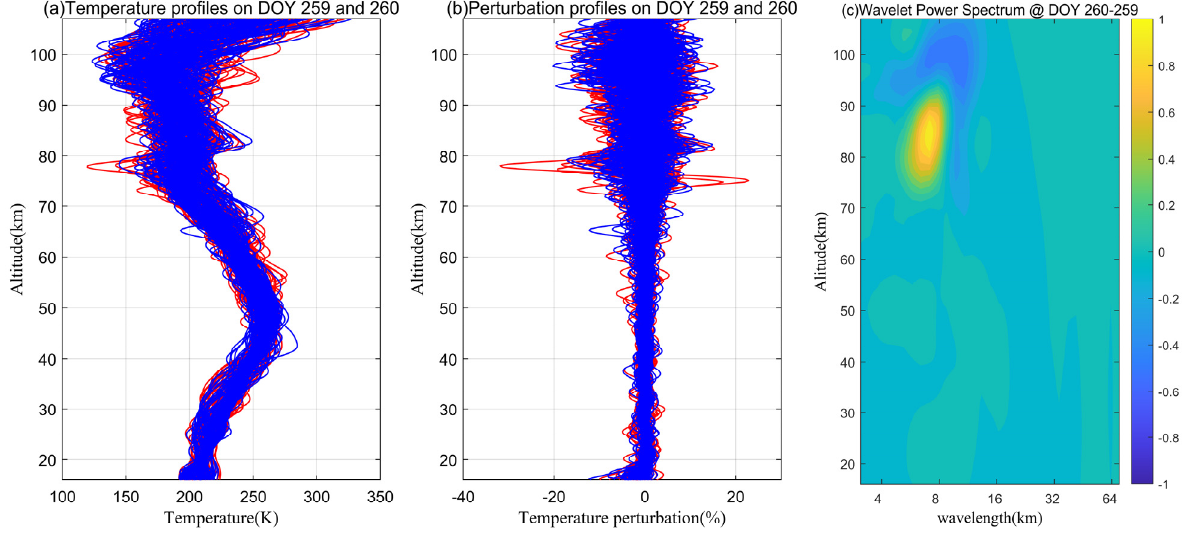
Figure 4. ( a ) Temperature profiles detected by the SABER datasets on DOY 259 (blue) and 260 (red) of 2015. ( b ) The corresponding temperature perturbation profiles. ( c ) The corresponding wavelet power spectrum differences between DOY 259 and 260 of